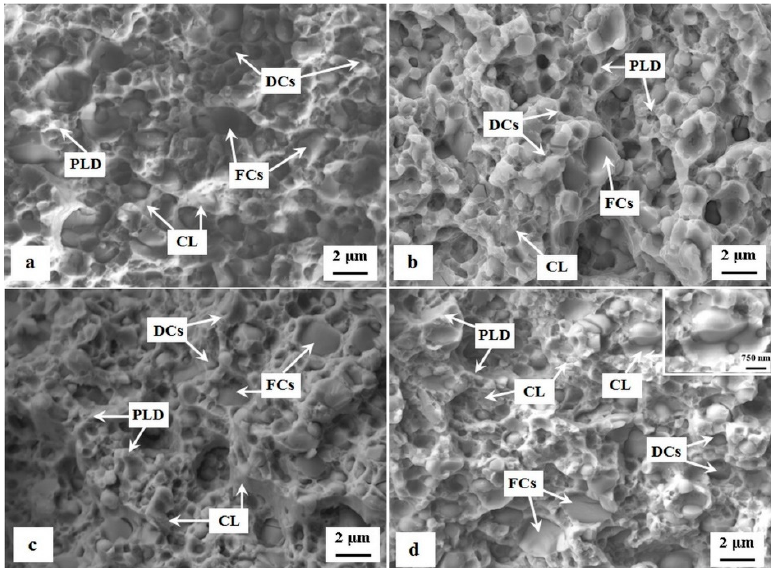
Figure 10. SEM micrographs showing details of the fracture surfaces of the specimens for the flexural strength after tempering at 170 °C: ( a ) CHT, ( b ) SZT at − 140 °C, ( c ) SZT at − 196 °C, and ( d ) strength after tempering at 170 ◦ C: ( a ) CHT, ( b ) SZT at − 140 ◦ C, ( c ) SZT at − 196 ◦ C, and ( d ) SZT SZT at − 269 °C. DC—decohesion at the matrix/carbide interface; FCs—fractured carbides;